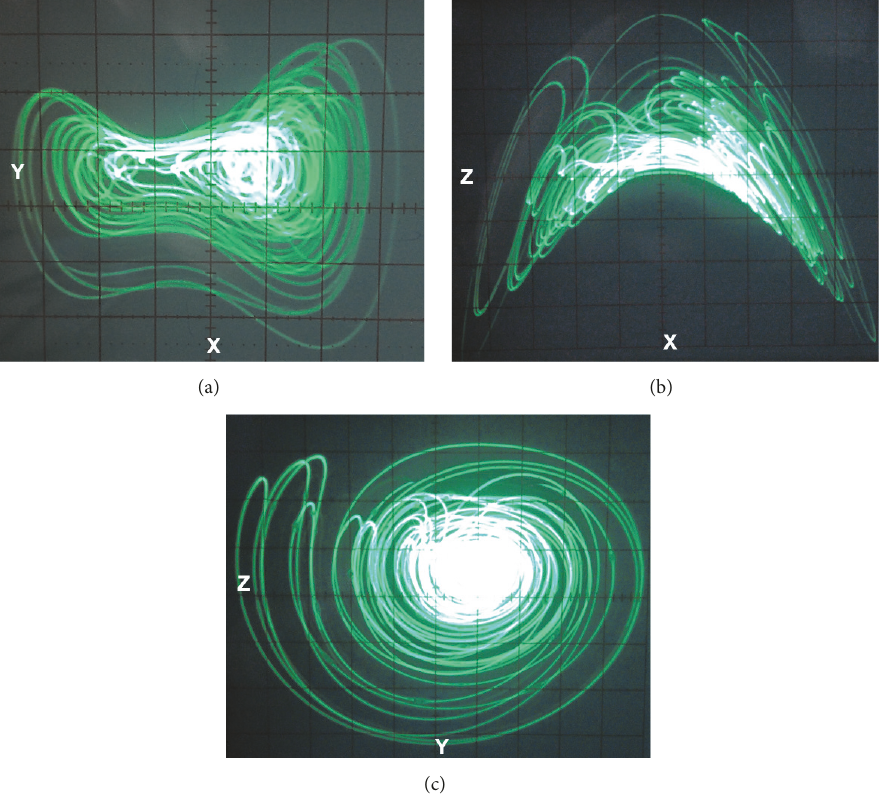
Figure 5: All phase portraits of the scaled chaotic system on the oscilloscope: (a) 𝑋 − 𝑌 plane, (b) 𝑋 − 𝑍 plane, and (c) 𝑌 − 𝑍 plane.